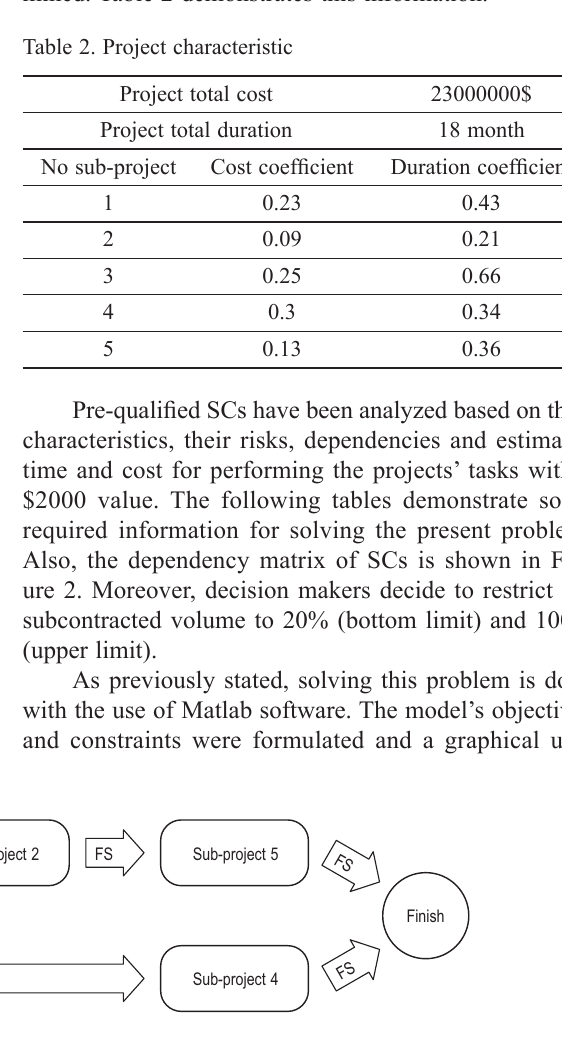
Fig. 1. The network of